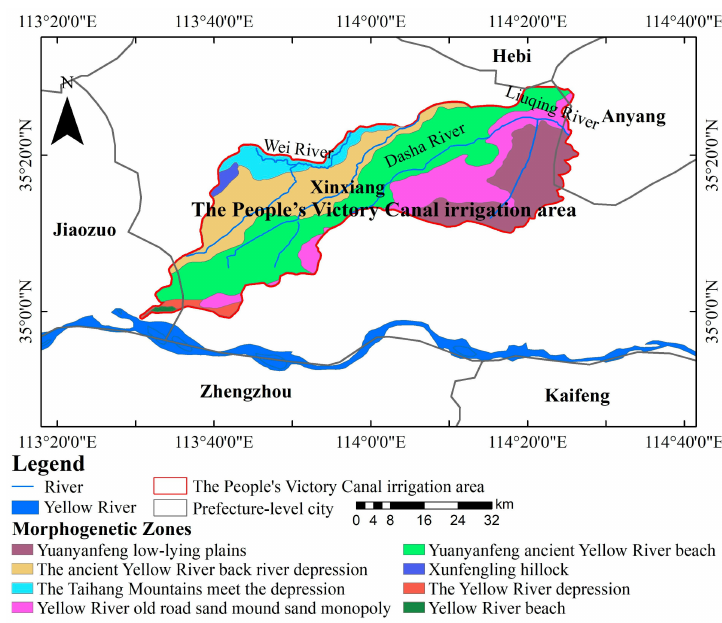
Figure 1. Study area